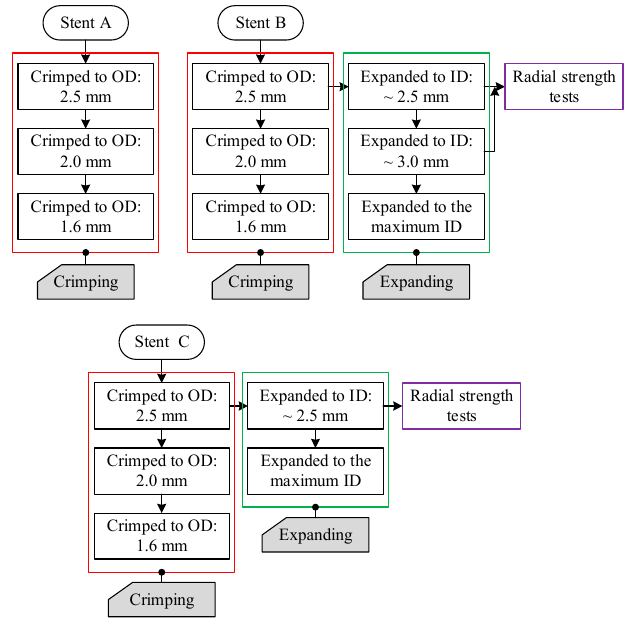
Figure 6. Deformation experiments of the tubular stents with the three design patterns to characterize crimping deformability, expanding deformability, and radial strength. OD: outside diameter; ID: inside diameter.